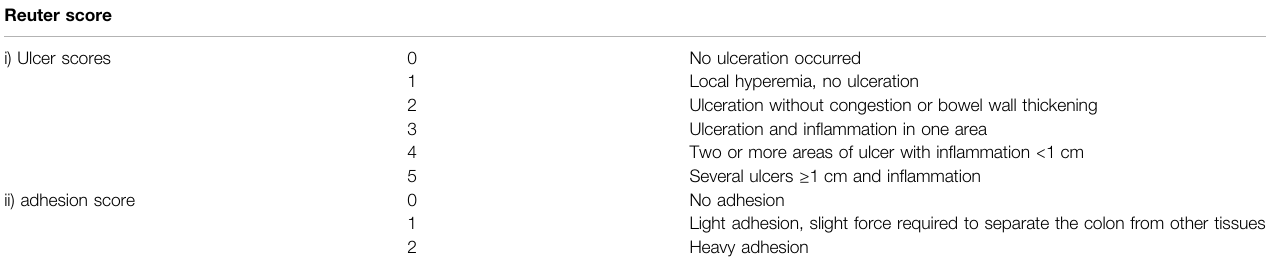
TABLE 1 | Ulcer score and Reuter score determination.